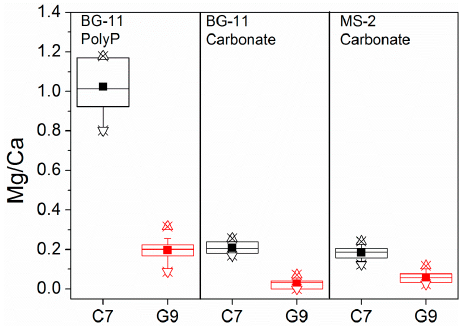
Figure 4. Box charts of atomic ratios of Mg/Ca of individual carbonate and polyphosphate (PolyP) inclusions of Ca . G. lithophora C7 and Ca . S. calcipolaris G9 cells grown in BG-11 and MS-2.